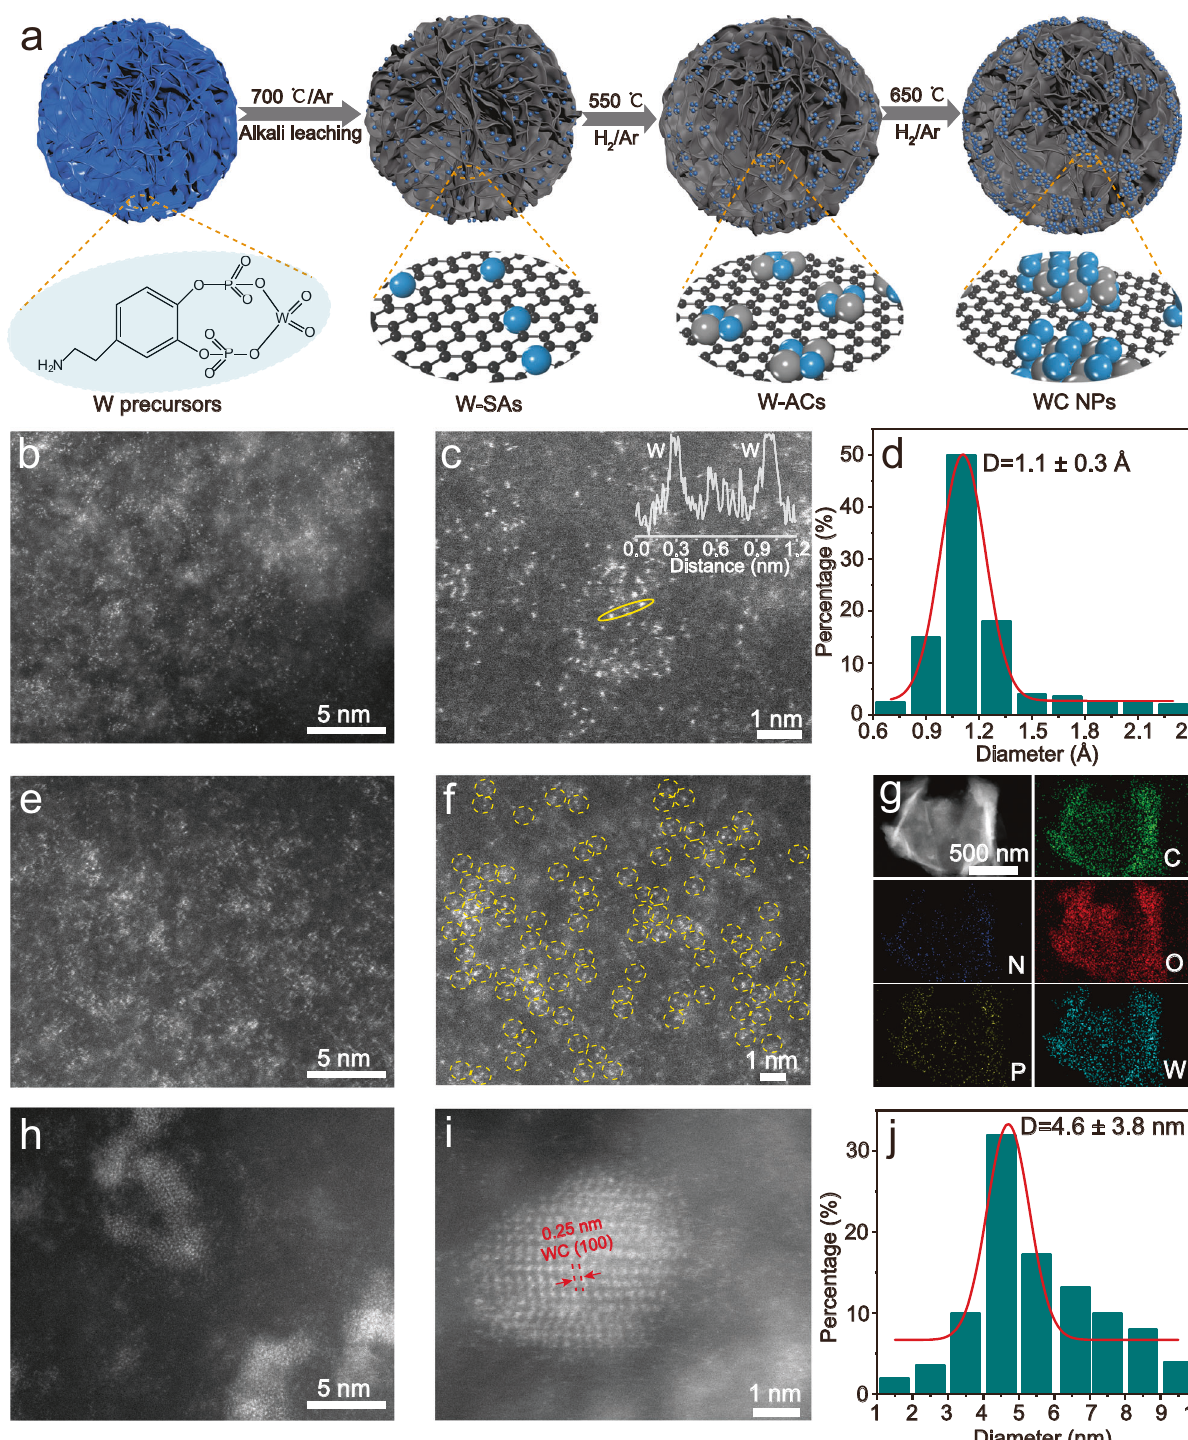
Fig. 1 Morphological characterization of the synthesized W-ACs. a Schematic illustration of the synthesis of W-SAs, W-ACs and WC NPs at H 2 /Ar atmosphere (1 bar), where W atoms, carbide carbon, and graphitic carbon is represented by blue, gray, and black spheres, respectively. Typical HAADF- STEM images of ( b ) W-SAs, e W-ACs, h WC NPs. c Enlarged STEM image of W-SAs, inset shows the intensity pro fi le along the tungsten atoms indicated by the yellow solid circle. d Statistical analysis of the lateral dimension of atomically dispersed tungsten atoms in ( b ) and Supplementary Fig. 4c. f Enlarged STEM image of W-ACs, with the W-W structures indicated by the yellow dashed circles. g STEM-EDS mapping of W-ACs showing the homogeneous distribution of C (green), N (deep blue), O (red), P (yellow) and W (cyan) elements. i High-magni fi cation HAADF-STEM image of a WC NP showing the (100) facet with lattice fringe spacing of 0.25 nm. j Statistical analysis of the lateral dimension of WC NPs in ( h ) and Supplementary Figs. 5b,